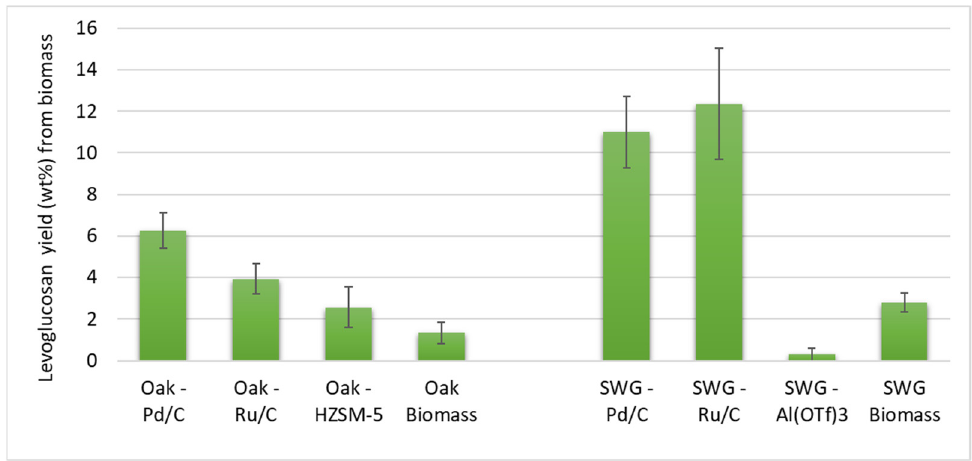
Figure 5. Levoglucosan yield (wt %) from pyrolysis of cellulosic pulps isolated after lignin-first fractionation in ethanol at 210 ◦ C, based on total biomass input. Pyrolysis at 550 ◦ C. Error bars are one standard deviation. Table 5. Yields of selected compounds from pyrolysis of cellulosic pulps isolated after lignin-first fractionation in ethanol at 210 ◦